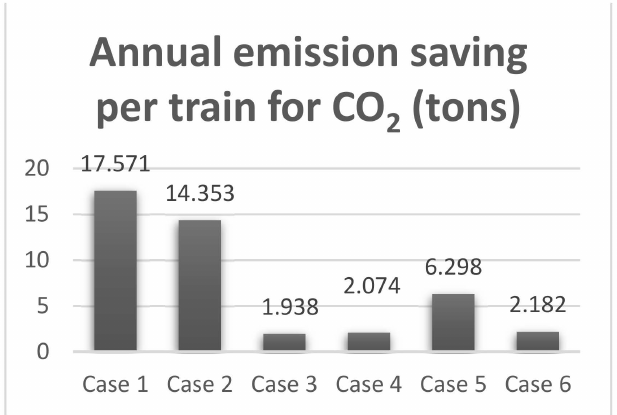
Figure 10. Comparison of annual emission saving per train for CO 2 (tons) for the six cases when using the electric brake regenerative